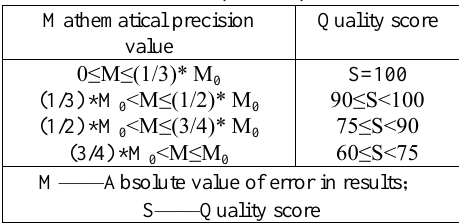
Table 4 . Mathematical accuracy scoring standards.